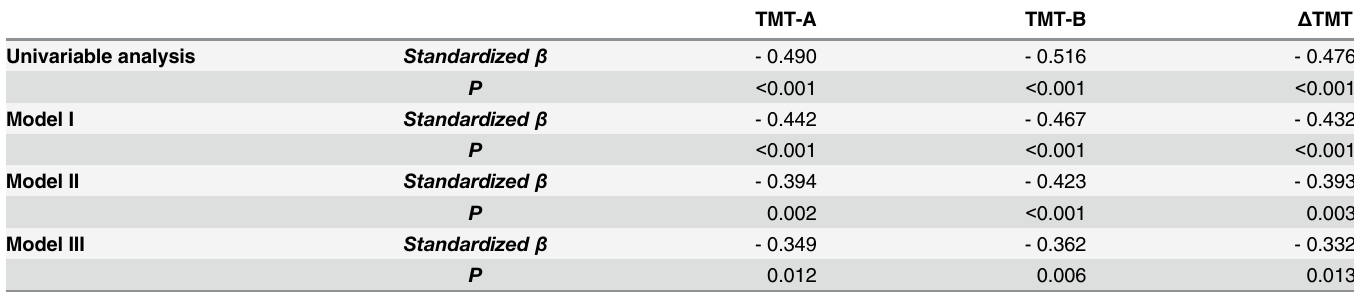
Table 3. Univariable and Multivariable-Adjusted Regression Analyses of Correlation between Normalized Whole-Brain GMV and TMT Scores in All Participants. Model I: Multivariable analysis adjusted for sex and age. Model II: Model I + diabetes mellitus, estimated glomerular filtration rate, and educa- tion. Model III: Model II + systolic blood pressure, smoking habits, drinking habits, hemoglobin, previous history of cardiovascular disease, and log-trans- formed urinary protein to creatinine ratio. Abbreviations: TMT, Trail Making Test.